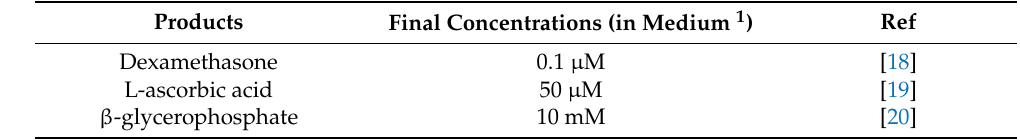
Table 1. Supplements added to the osteogenic differentiation medium used in this